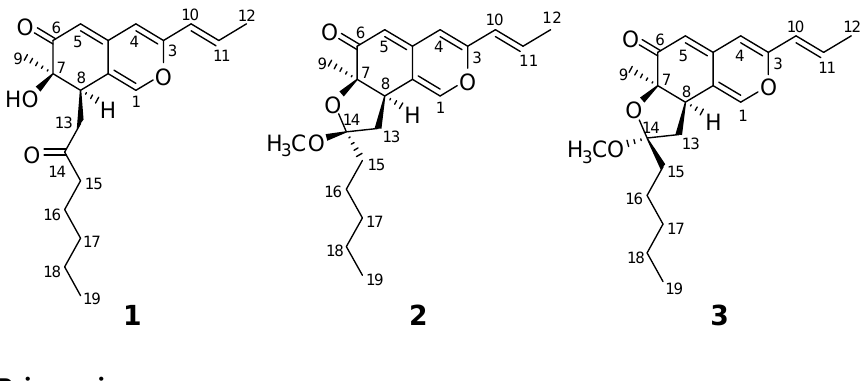
Figure 1. Chemical structures of compounds 1 , 2 and 3